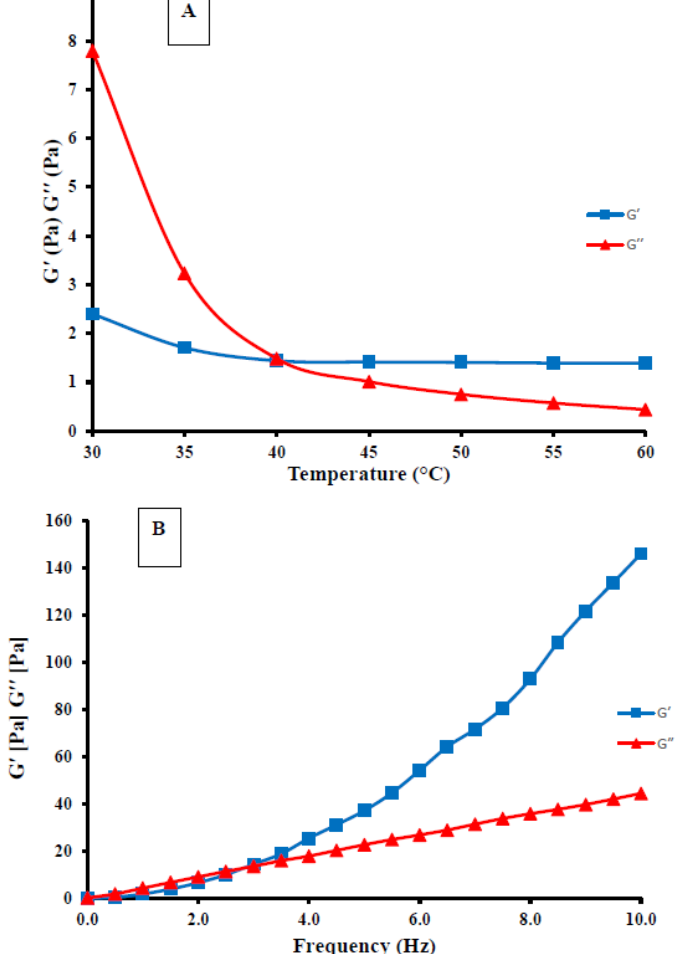
Figure 5. Viscoelastic characterization of CTO changes in storage modulus (G ′ ) and loss modulus (G ″ ) ( A ) Temperature sweep ( B ) Frequency sweep.